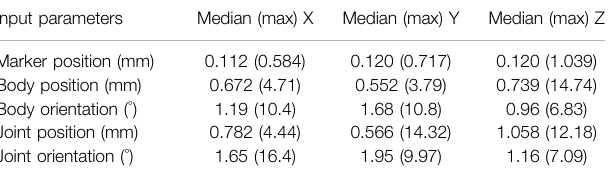
TABLE 3 | Operator-dependent input parameters.